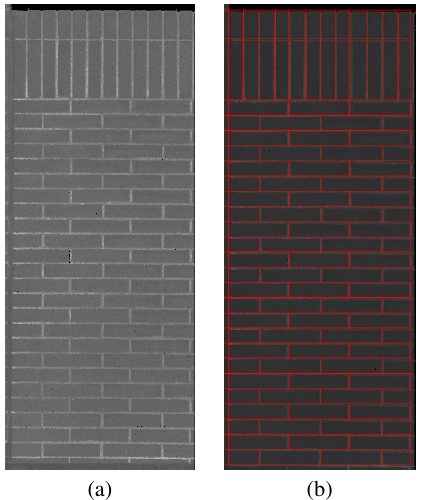
Figure 4. (a) Laser intensities (a) and (b) rough brick segmenta- tion.